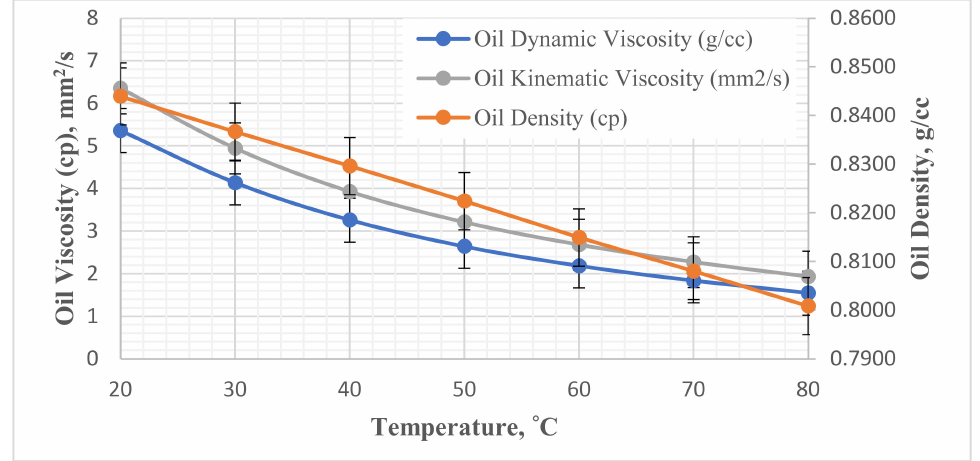
Figure 4. Physical properties of the crude oil